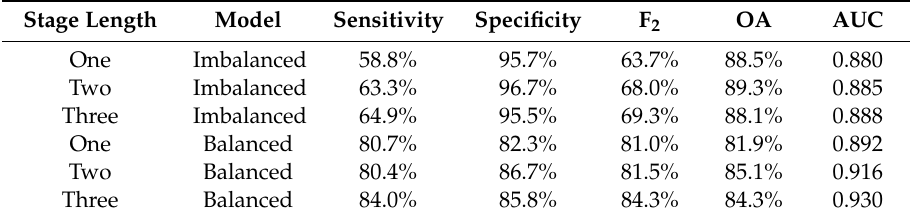
Table 3. Model predictions using an artificial neural network.